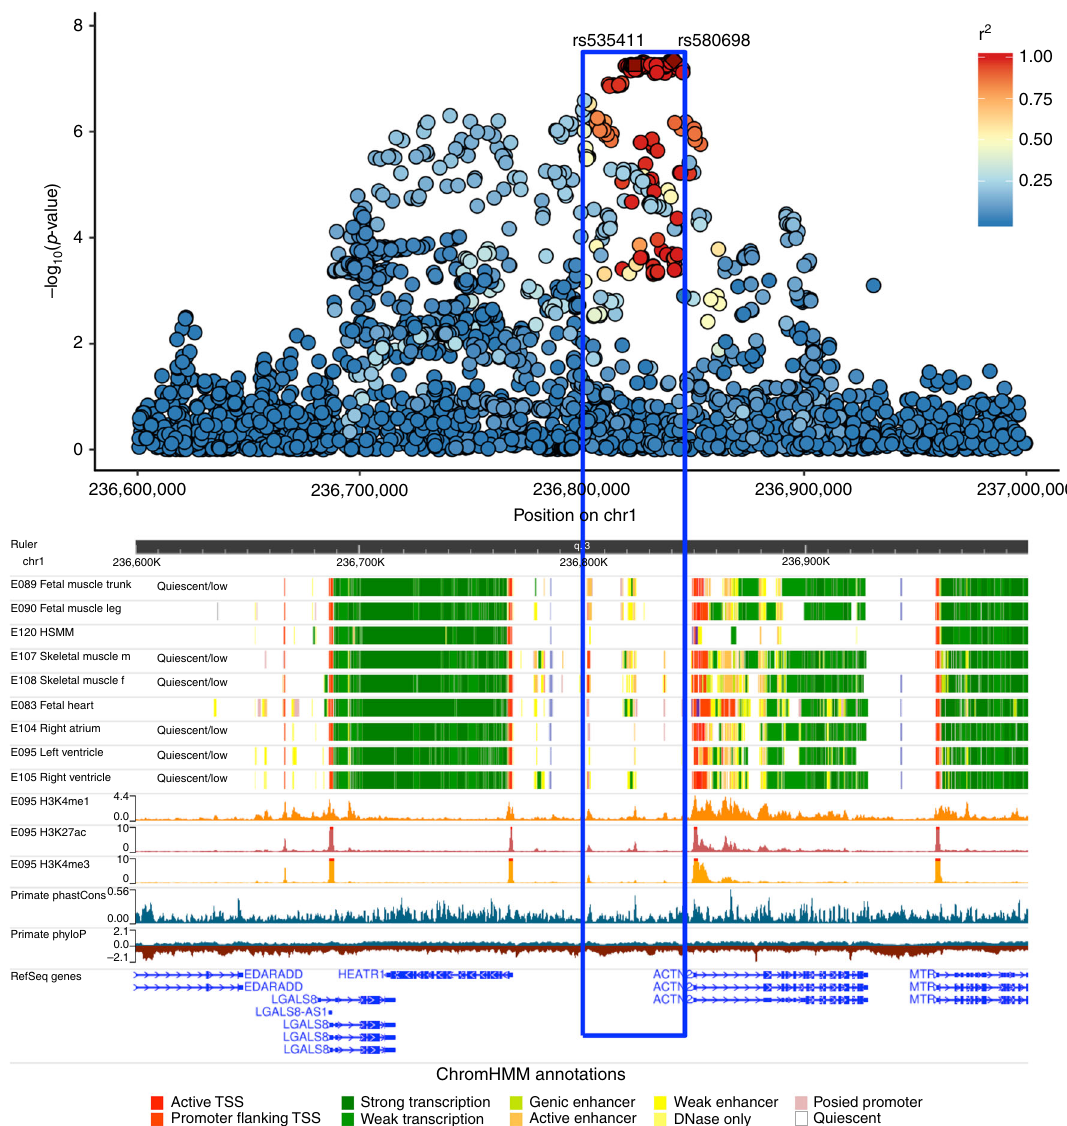
Fig. 2 Epigenetic overview of the ACTN2 locus. Manhattan plot of the ACTN2 locus and the corresponding Roadmap ChromHMM 25-state model annotations in cardiac and muscle cell-types and tissues, H3K4me1, H3K4me3, H3K27ac peaks in left ventricle, and phyloP and phastCons evolutionary conservation values. The blue box highlights the region that contains all 111 credible set variants identi fi ed by